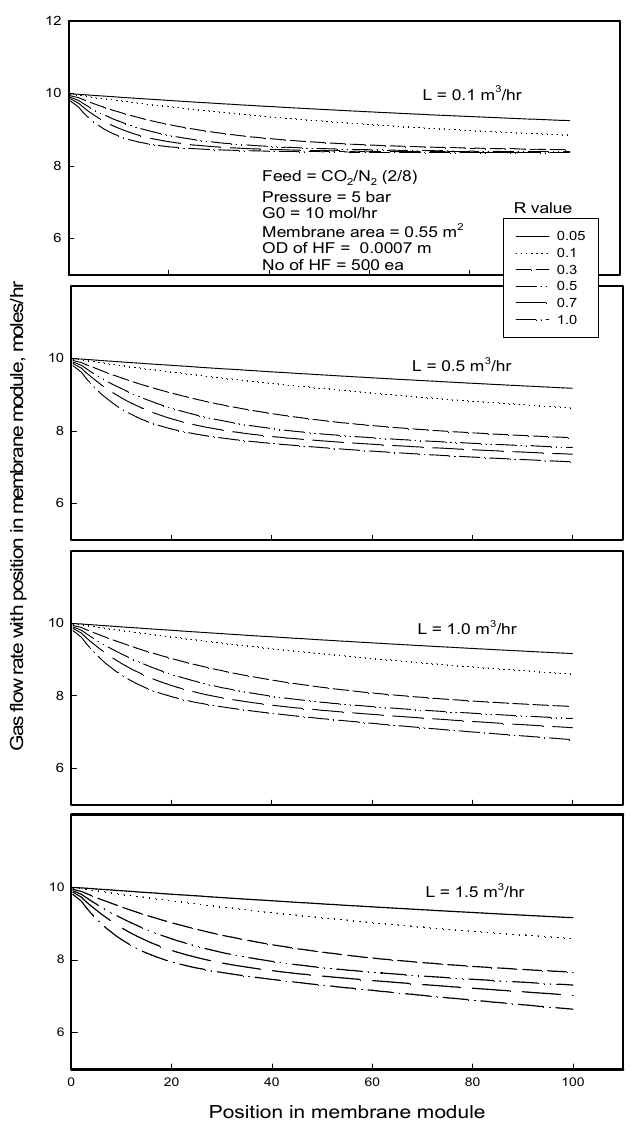
Figure 12. Gas flow rate in feed stream with the position of membrane module length in gassing process for the separation of CO 2 /N 2 mixture.